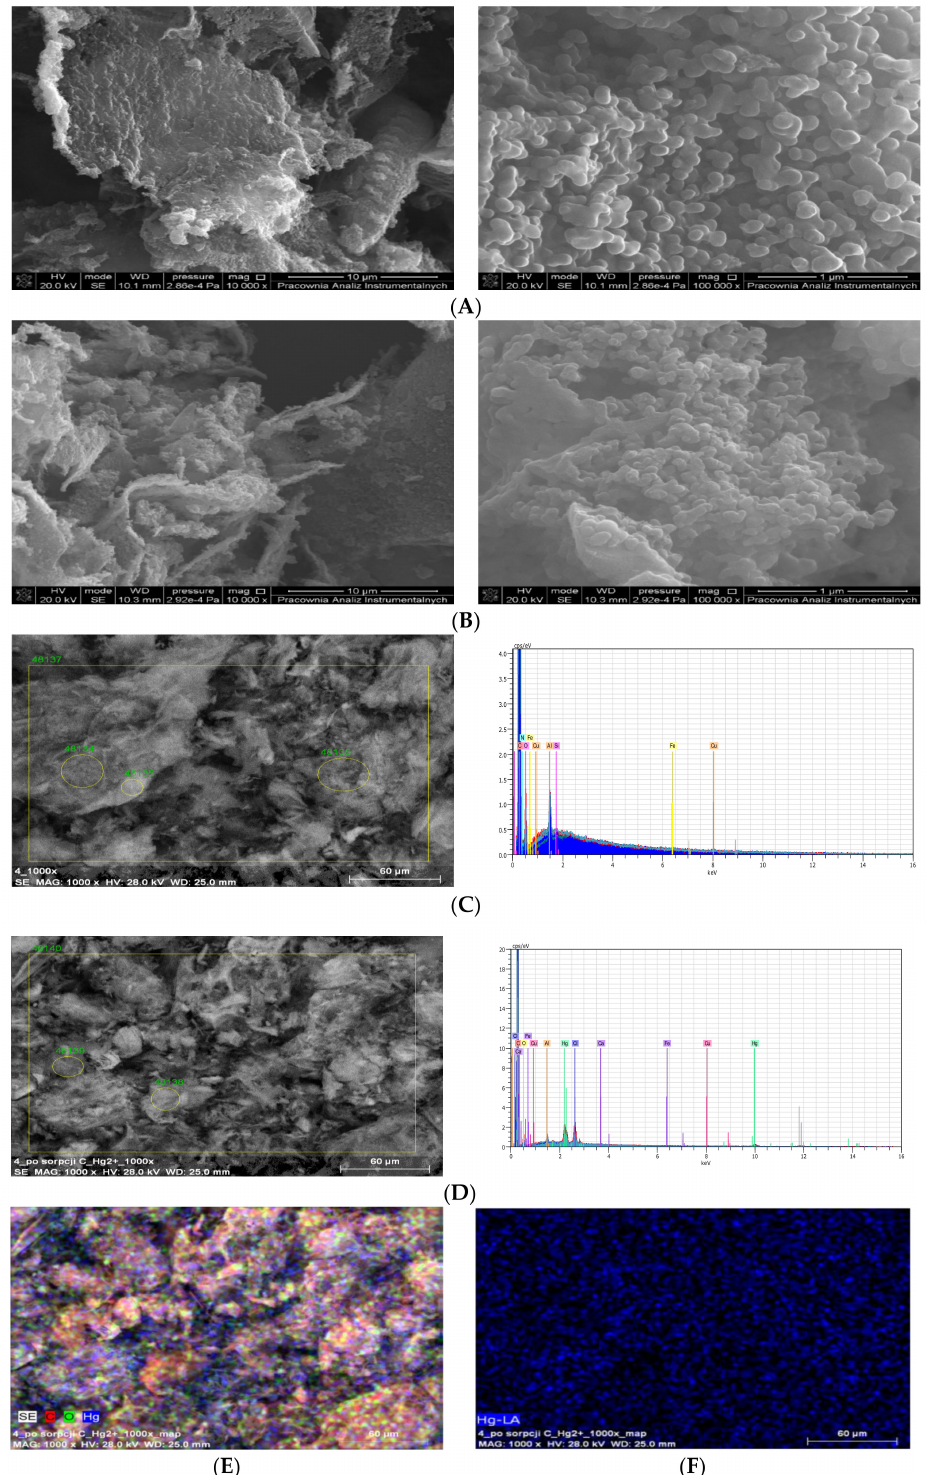
Figure 3. SEM microphotographs: ( A ) obtained hydrochar, ( B ) hydrochar after mercury